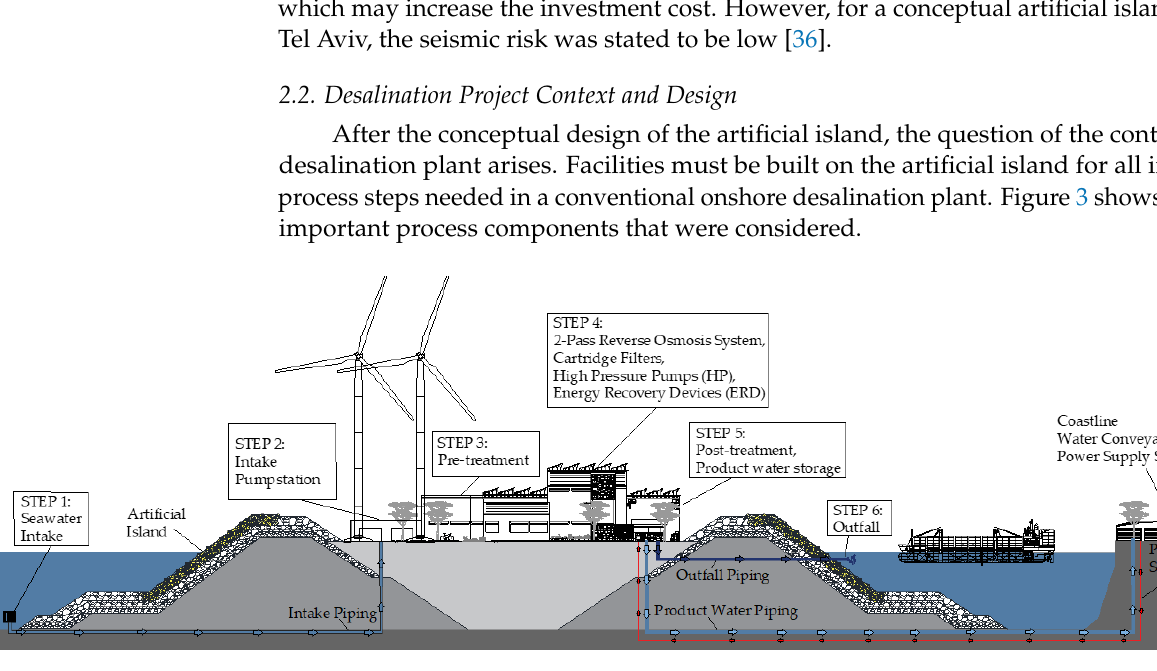
Figure 3. Desalination project context on the artificial islands.